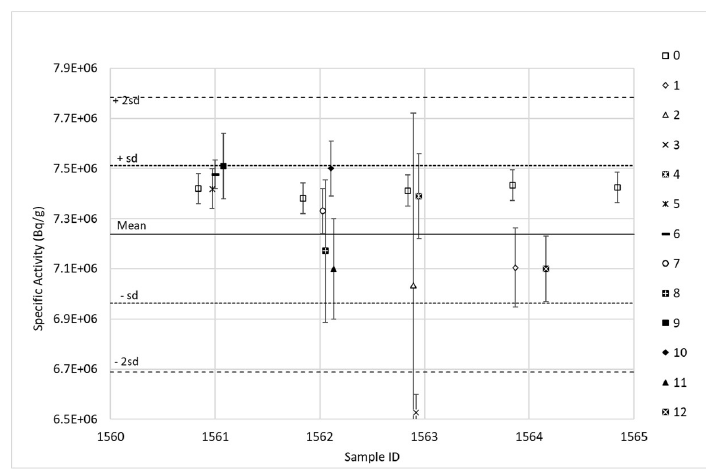
Fig. 5 Specific activity measurements obtained for 110m